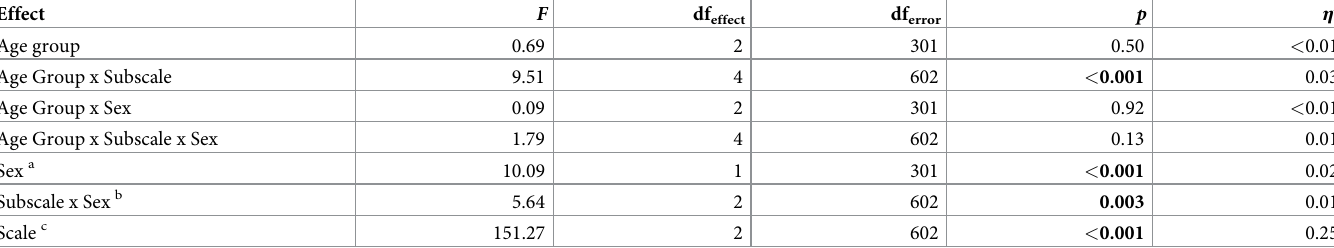
Table 1. Aging and emotional awareness. Results of the analysis of variance with the three factors age group (young, middle, older), sex (male/female), and subscale (within factor: DIF, DDF, EOT).